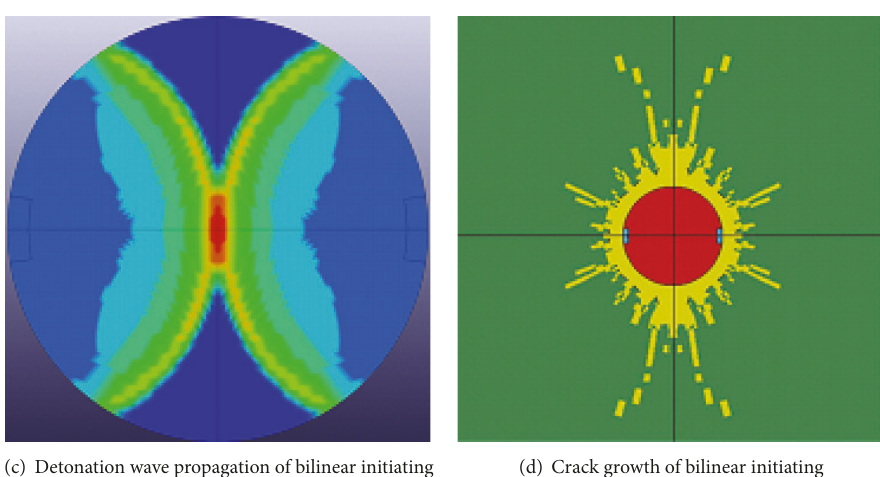
Figure 7: Detonation wave propagation and crack growth under two different initiating